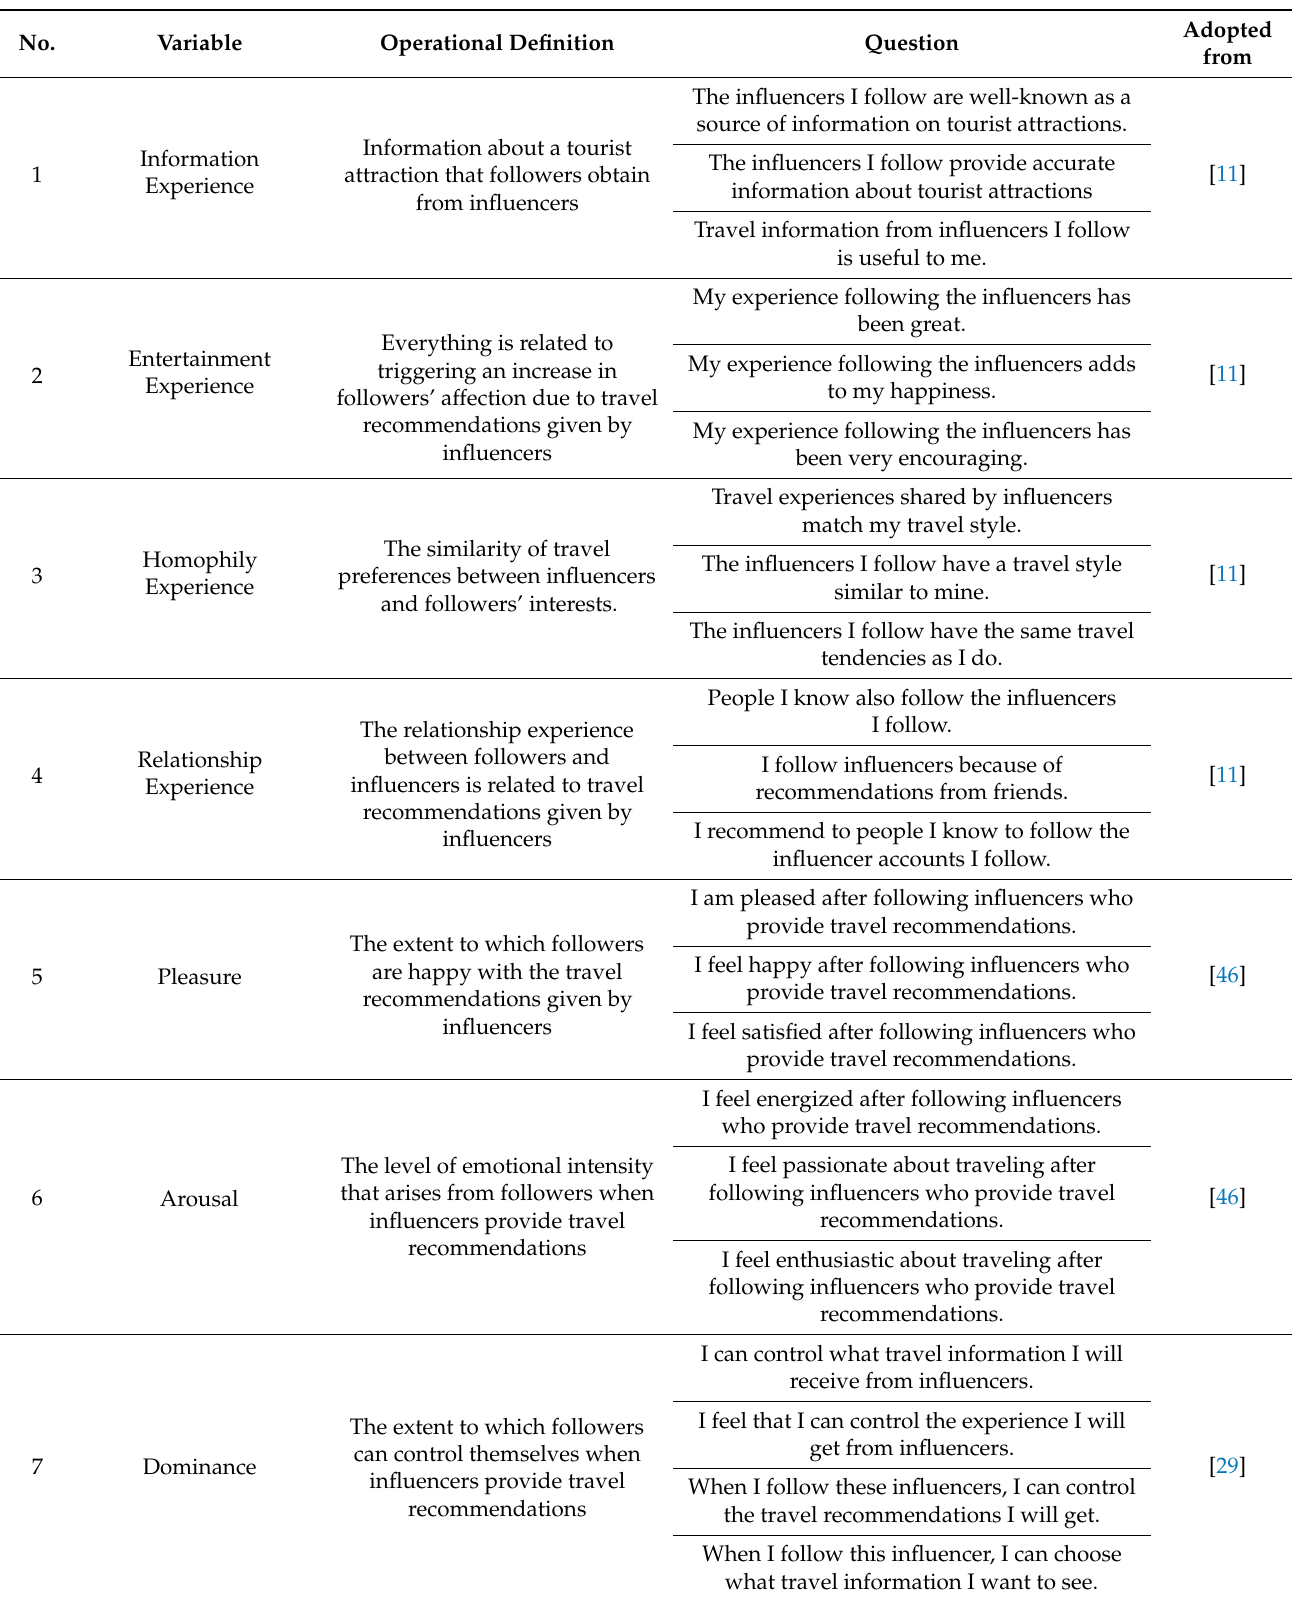
Table 1. Research